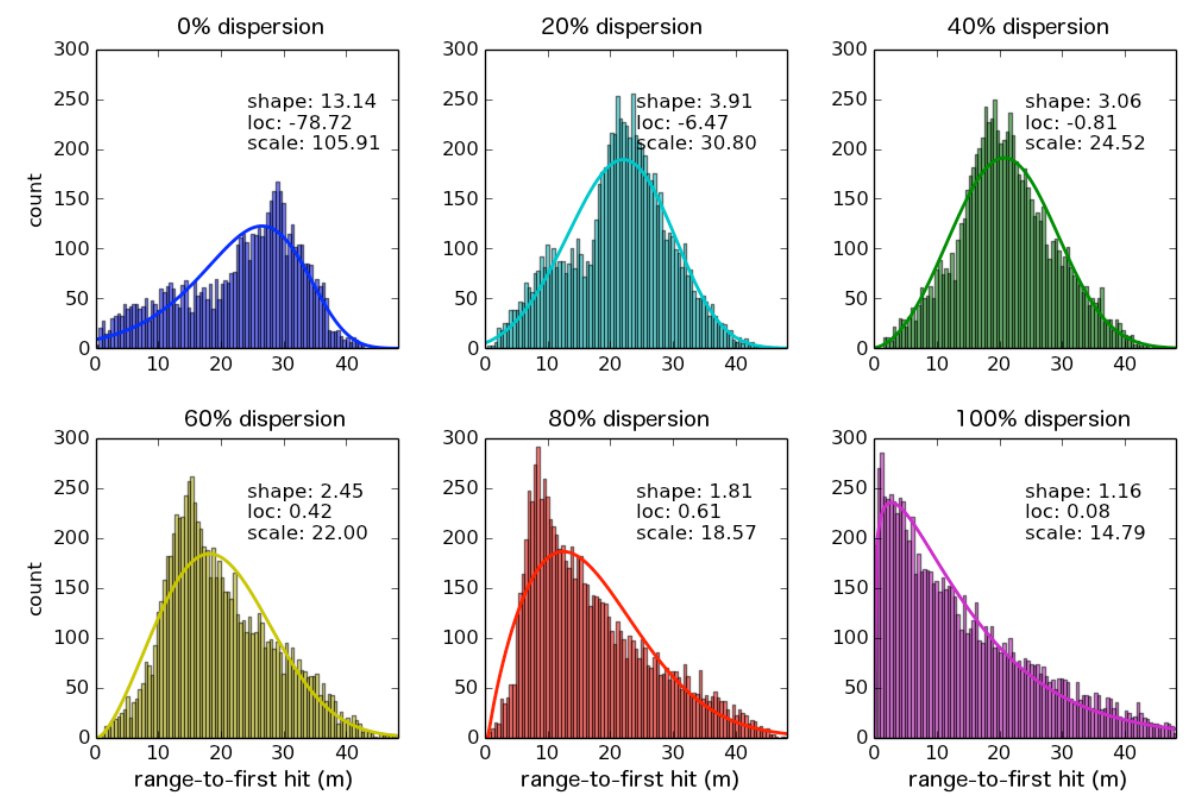
Figure 7: Distribution in range-to-first hit for different degrees of foliage clumping for the virtual mixed stand. The histograms show a transition from a bimodal distribution towards a negative exponential distribution, according to a change from clumped- (top-left) to uniform (bottom-right) foliage